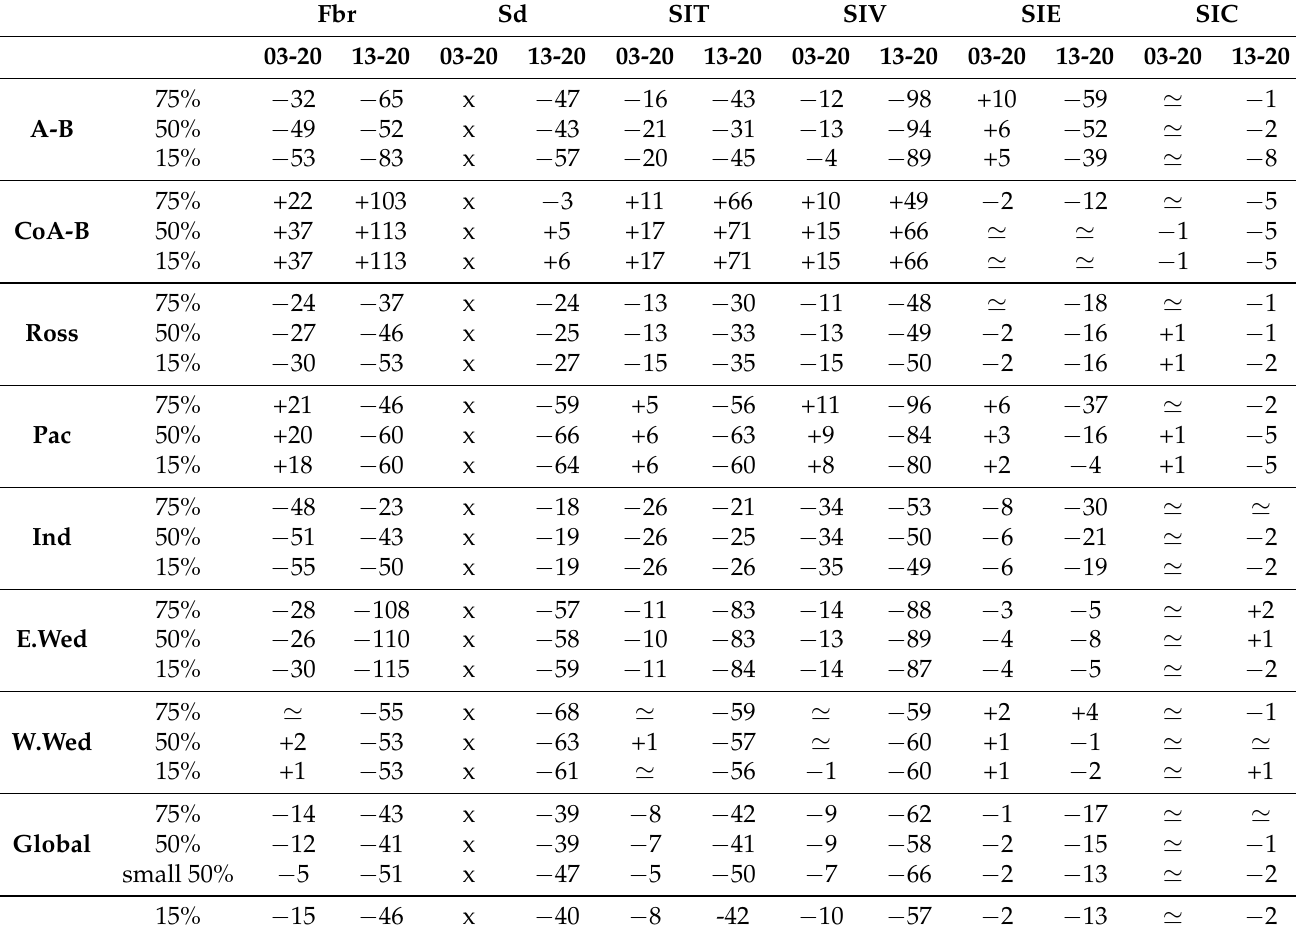
Table A1. 2003–2020 and 2013–2020 trends (in % per decade) of the variables analysed in Section 3.4. The radar freeboards trends are calculated from the CS2-TFMRA50 dataset and the snow depth from the ASD product (only for 2013–2020). The SIT and SIV trends are computed from CS2- TFMRA50+AMSR-clim over 2003–2013 and from CS2-TFMRA50+ASD over 2013–2020. The NSIDC Sea ice extent and concentration trends are also indicated. The trends are calculated for sea ice concentration higher than 75%, 50% and 15%. Only for the global Antarctic, trends are also calculated for the smallest area with concentration higher than 50% over 2003–2020 (small 50%). It corresponds to the trends of the series presented in Figure